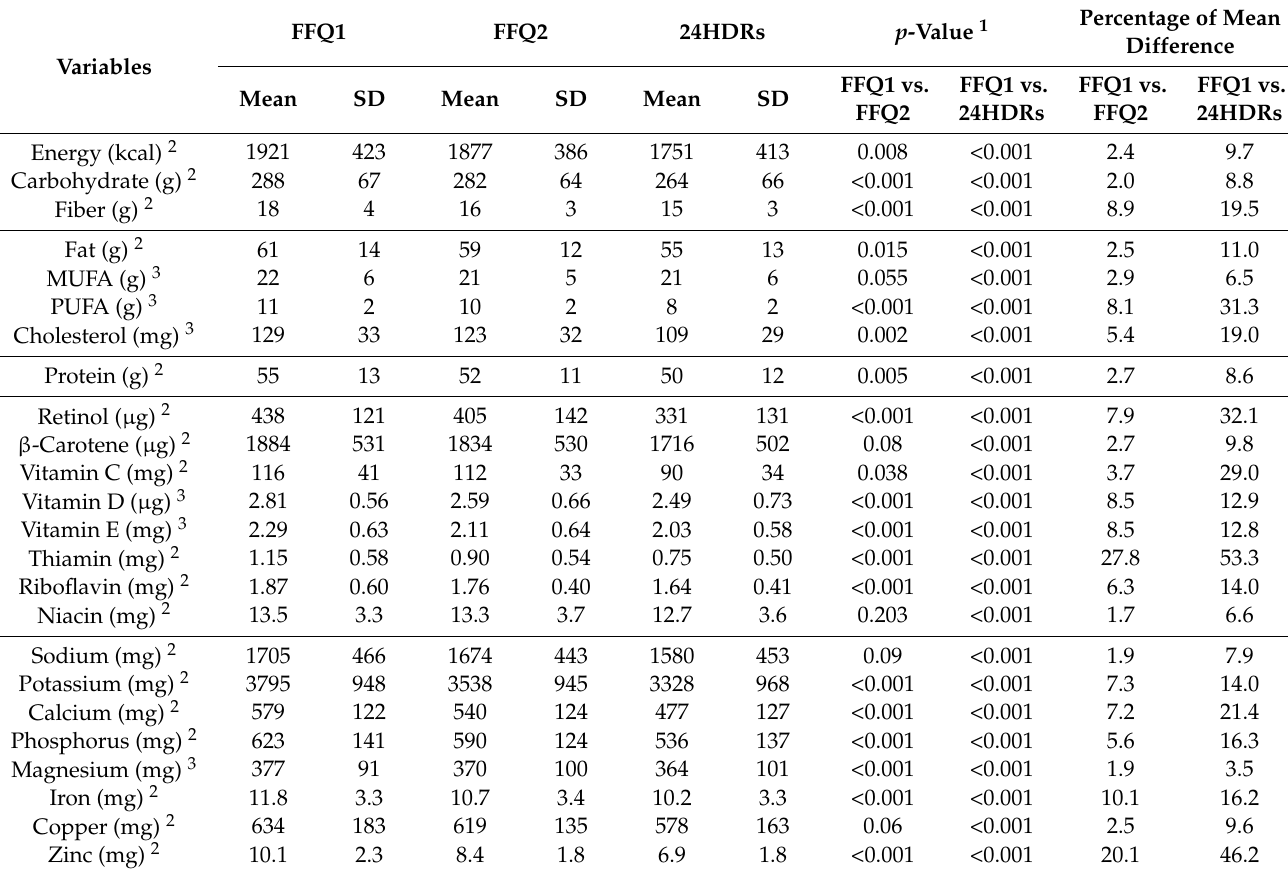
Table 3. Comparisons of nutrient intakes between two FFQs and between FFQ1 and the mean of 24HDRs.